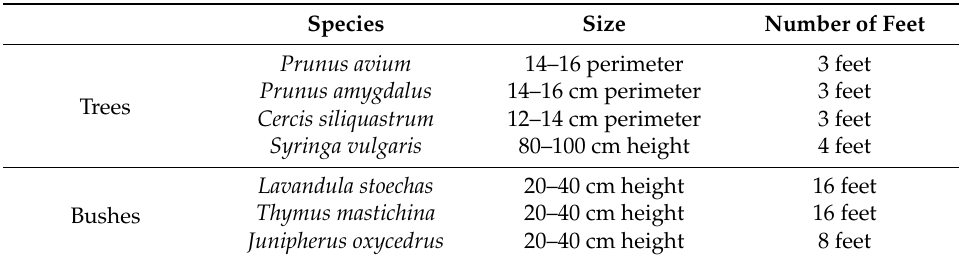
Figure 6. Up: ( A ) Project plan of environmental and landscape restoration: Avenues and landscape restoration; ( B ) Main channel; ( C ) Roads and walkways network; ( D ) Play structures for children, designated areas for dogs; ( E ) Vegetable species distribution; ( F ) anaglyphs of vegetation and 3D restoration: BIM analysis. Down: Virtual modeling near of channel of the decorative furnishings. Table 5. Species selected for inner planting of Zone J.